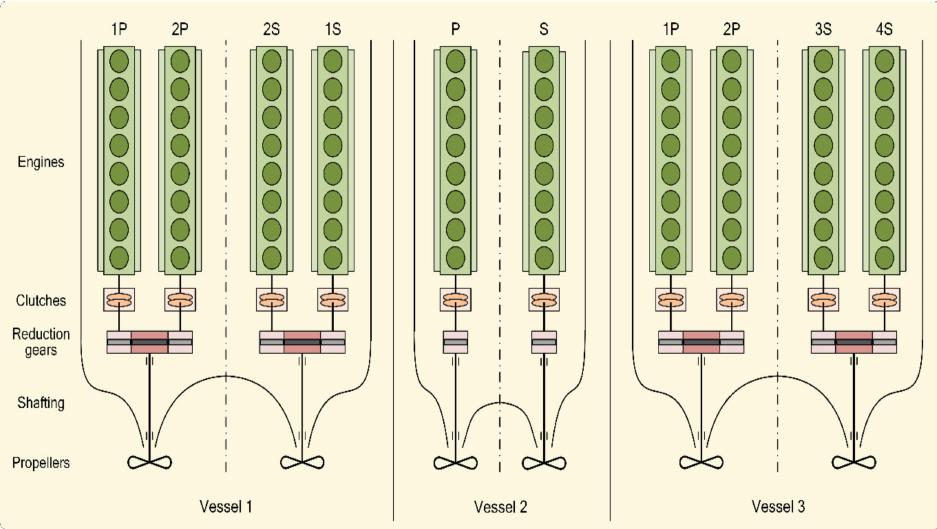
Figure 6. Layouts of propulsion